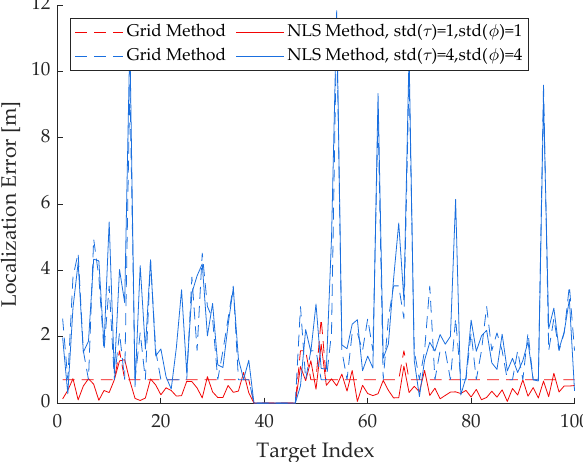
Figure 7. Localization error of the proposed algorithm at different locations.